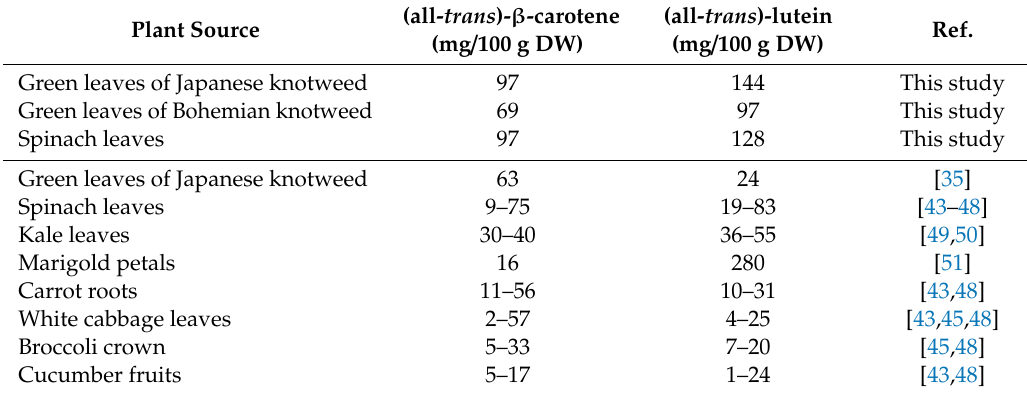
Table 3. Contents of lutein and β -carotene in di ff erent plant